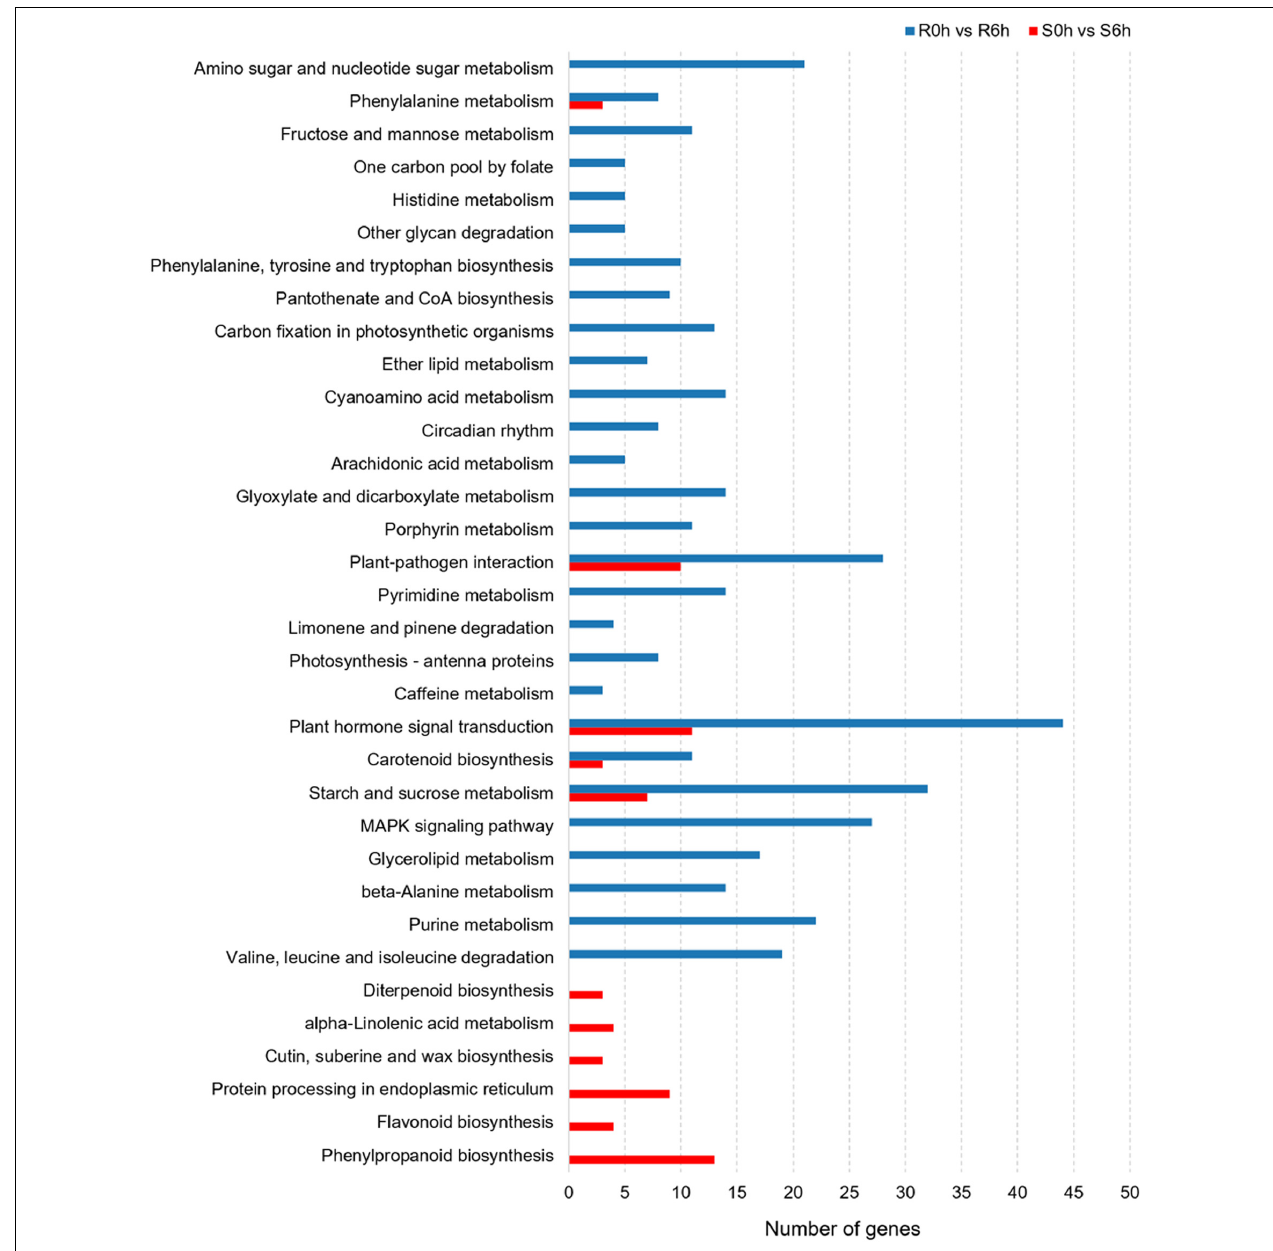
FIGURE 4 | KEGG pathway analysis of DEGs in PM-susceptible cucumber strain B21-a-2-2-2 and PM-resistant cucumber strain B21-a-2-1-2 subjected to infection with P. xanthii .